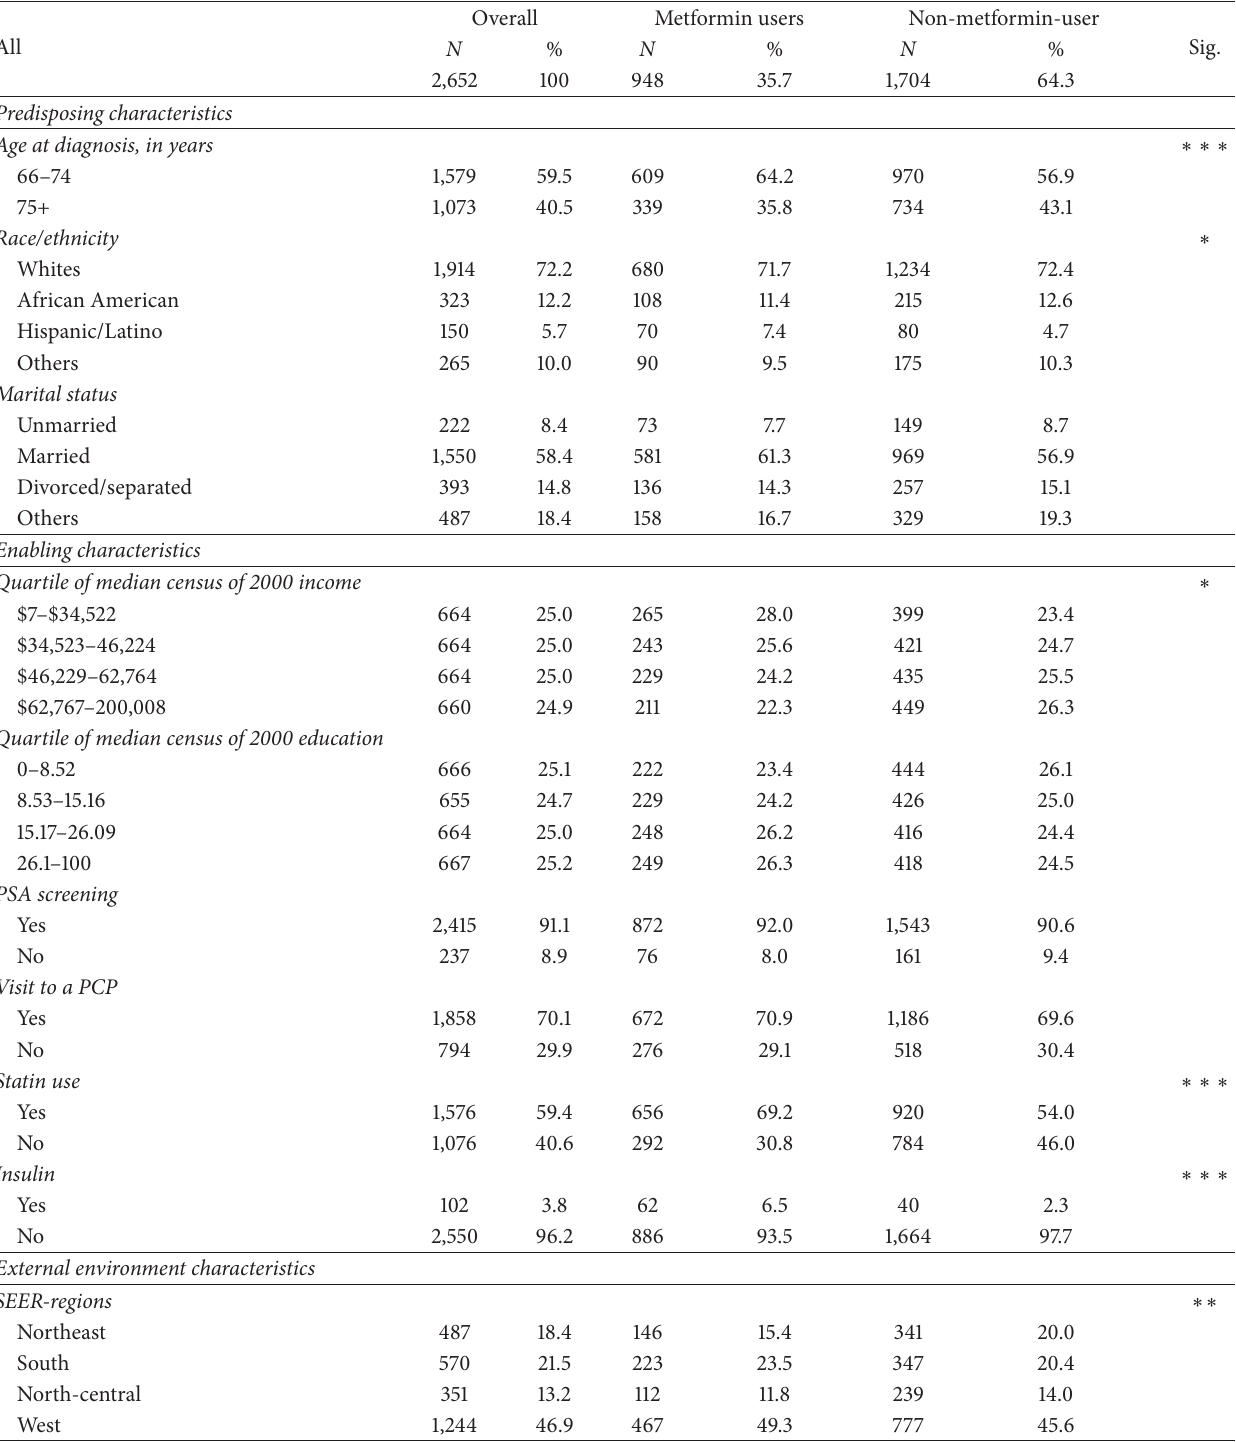
Table 1: Characteristics of the study cohort elderly Medicare beneficiaries with diabetes and incident prostate cancer by metformin use SEER-Medicare linked database,